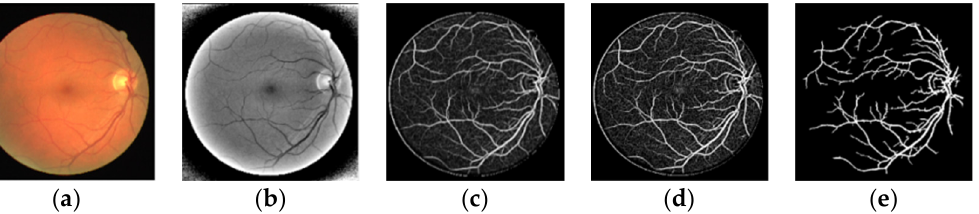
Figure 1. The flow chart of the proposed algorithm for vessel extraction.